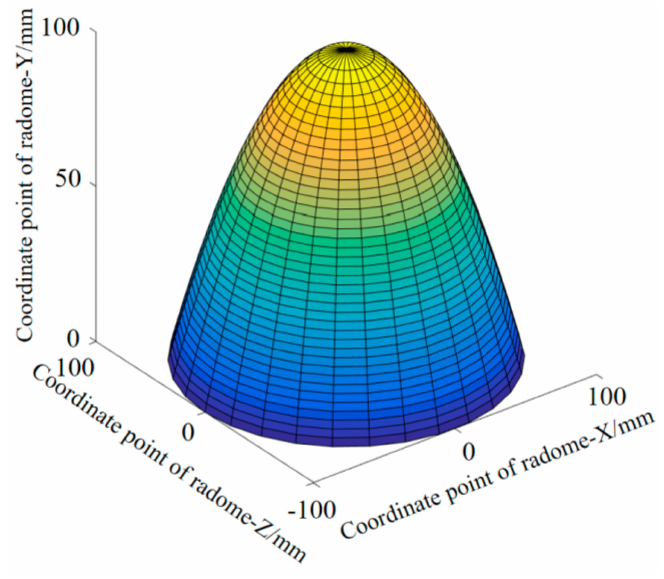
Figure 4. Three-dimensional model diagram of the Fourier approximation fitting